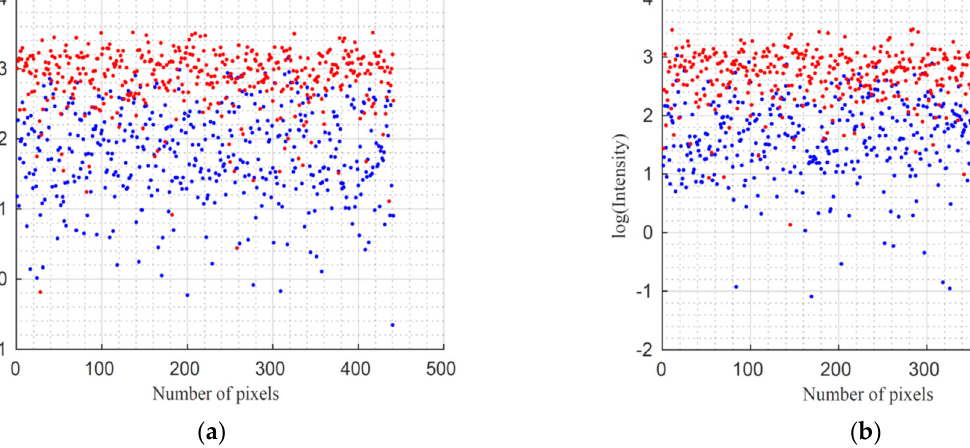
Figure 5. GF plot for a number of pixels versus intensity ( a ) Variance ( b ) Contrast (red dots represent non ‐ infected pixels and blue dots represent the infected region).